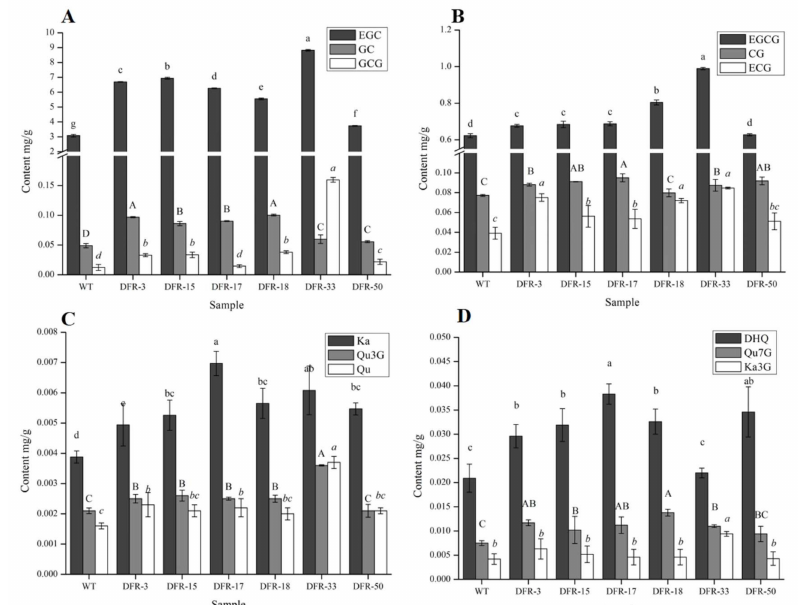
Figure 6. The content of flavonoids and polyphenols in flowers of transgenic tobaccos. ( A ) The content of EGC (epigallocatechin), GC (gallocatechin) and GCG (gallocatechin gallate) in flowers of tobaccos. ( B ) The content of EGCG (epigallocatechin gallate), CG (catechin gallate) and ECG (epicatechin gallate) in flowers of tobaccos. The contents of EGC, GC, GCG (except DFR-17), EGCG (except DFR-50), CG (except DFR-18) and ECG (except DFR-50) in the positive lines were significantly higher than those in the wild type tobacco except one line. ( C ) The content of Ka (kaempferol), Qu3 G (quercetin-3-O-glucopyranoside) and Qu(quercetin) in flowers of tobaccos. ( D ) The content of DHQ (dihydroquercetin), Qu7 G (quercetin-7-O- β -D-glucopyranoside) and Ka3 G (kaempferol-3-glucopyranoside) in flowers of tobaccos. DHQ (except DFR-33) and Ka in the positive lines were significantly higher than those in the wild type tobacco. The contents of flavonols (Qu3 G, Qu7 G and Ka3 G) have no significant change between the positive lines and the wild type. The letters represent the level of di ff